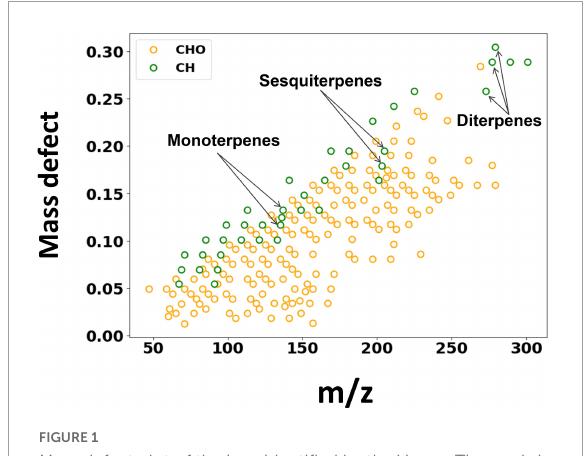
FIGURE1 Mass defect plot of the ions identified by the Vocus. The x axis is the mass-to-charge ratio and the y axis shows the mass defect, which is the deviation of the exact mass from the nominal mass. Data points are colored by their elemental